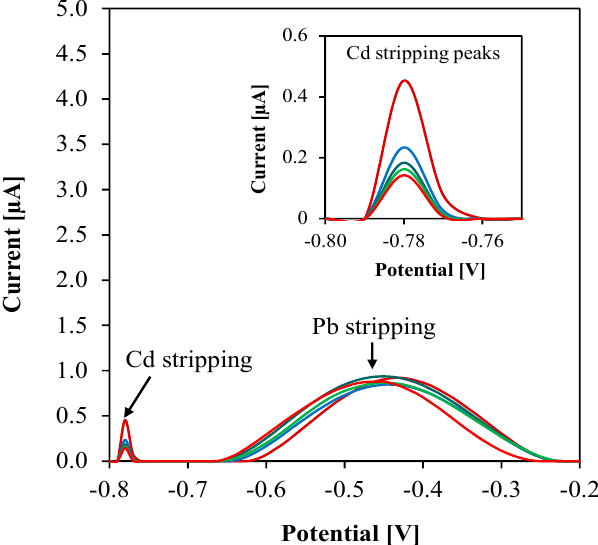
Figure 8. ASV of fixed 5 nM Pb with increasing concentrations of Cd in steps of 1 nM, 10 nM, 100 nM, 1 µM, 10 µM, and 100 µM using parameters from Table 3. Inset shows the Cd stripping peaks in magnified scale.